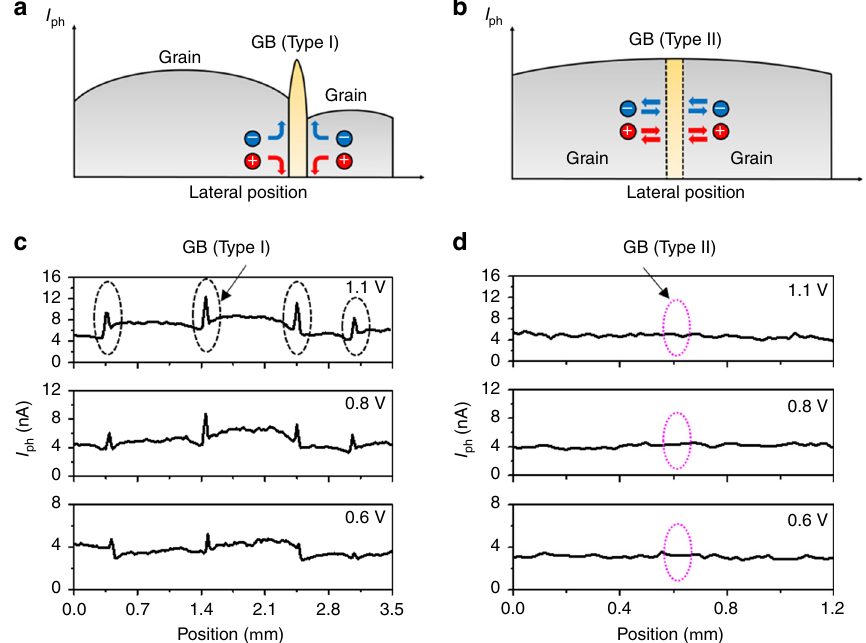
Fig. 5 Two GB types revealed in polycrystalline MAPbI 3 thin fi lm. a – b Proposed models of Type I and Type II GBs based on the pc-AFM and T-AFM results. c – d pc-AFM line scans during distinct tip-FTO biasing as noted across Type I ( c ) and Type II ( d ) GBs, revealing voltage-independent unique behavior. The two types of GBs are highlighted with black dashed oval and magenta dotted oval, respectively, here and in Fig. 3e, taken across the paths equivalently identi fi ed in Fig.